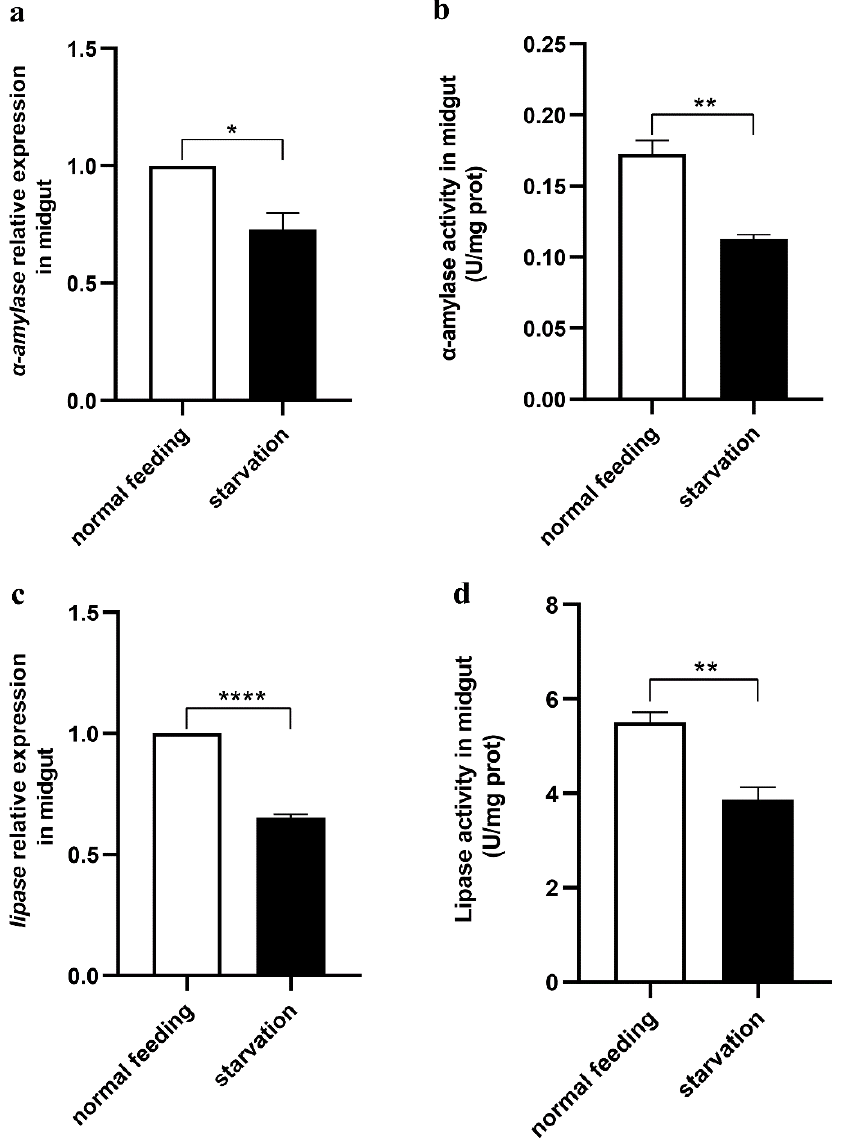
Figure 6. Effects of feeding on midgut α -amylase and lipase. ( a , c ) Relative expression levels of α -amylase and lipase in the midgut between larvae with normal feeding and 6 h starvation. ( b , d ) The enzyme activities of α -amylase and lipase in the midgut between larvae with normal feeding and 6 h starvation. Each treatment was repeated 3 times with 10 individuals per replicate. Bars represent the mean ± SE, * p < 0.05, ** p < 0.01, **** p < 0.0001.